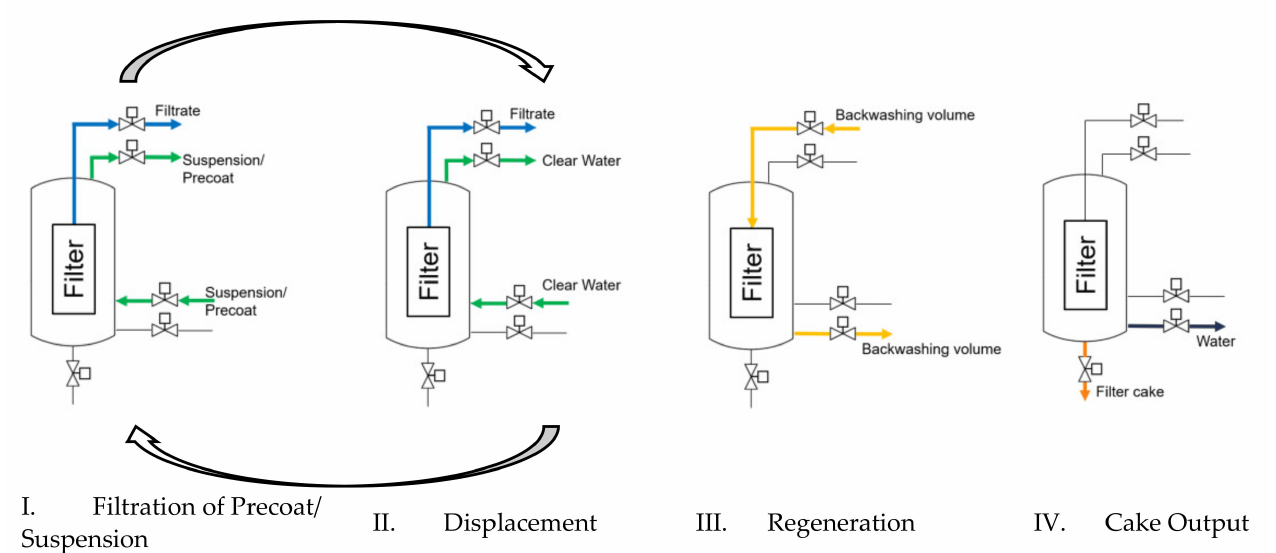
Figure 2. Schematic representation of the test plant during filtration of the precoat layer ( I ), displacement of the suspension with clear water ( II ), and subsequent running through of the same sequence with filtration of the suspension ( I ) and renewed displacement by clear water. This is followed by regeneration ( III ) through discharge of the filter cake and cake removal out of the process room ( IV